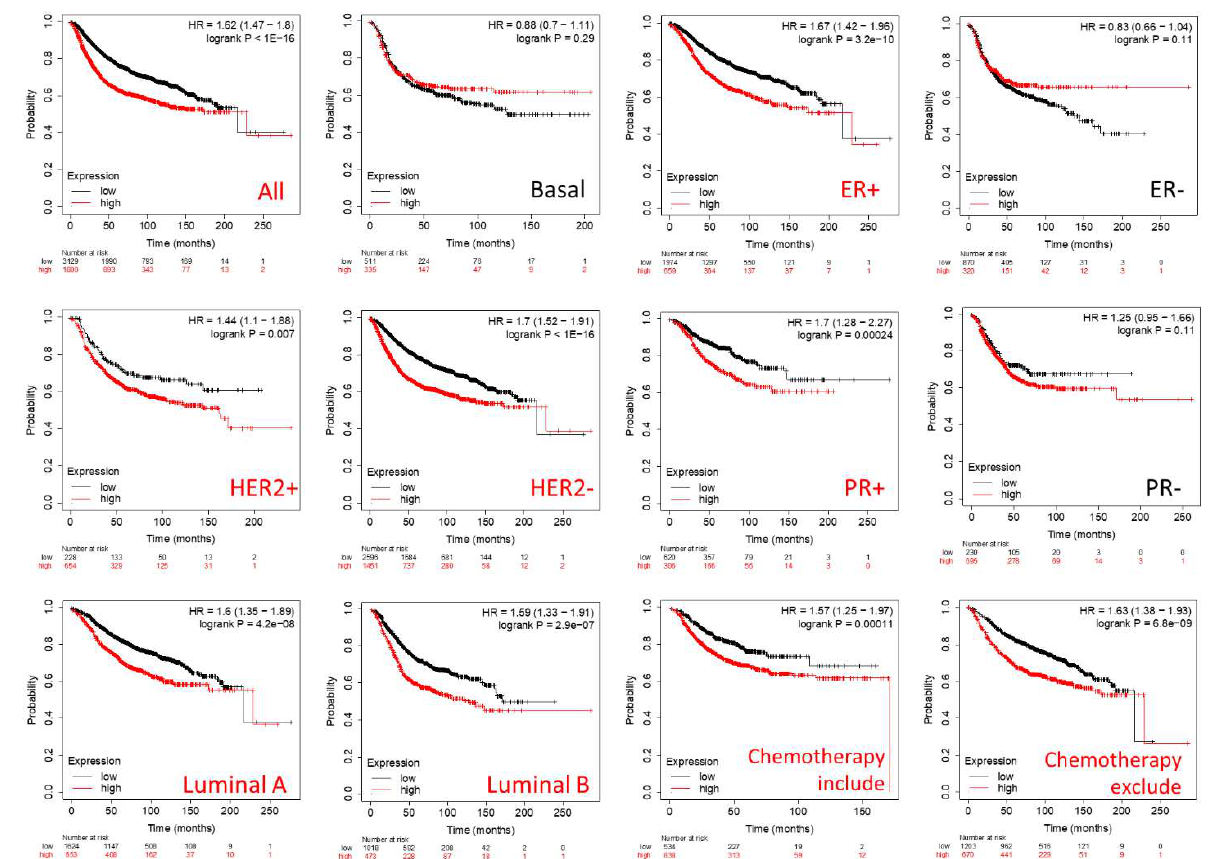
Figure 5. Distant metastasis-free survival (DMFS) analysis of GPSM2 in breast cancer (Kaplan–Meier plot). Red and black curves represent survival analysis for higher and lower GPSMs mRNA expression levels, respectively. Red and black titles indicate statistically and non-statistically significant survival, respectively. ER, estrogen receptor; HER2, human epidermal growth factor receptor 2; PR, progesterone receptor; +, positive; −, negative.